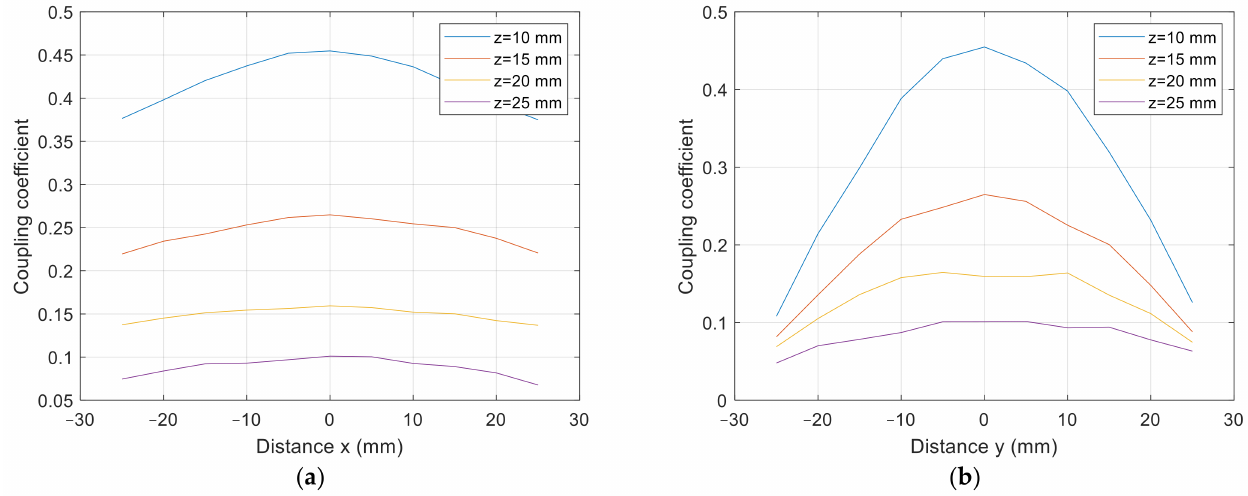
Figure 16. x - y coupling coefficient measurement of planar DD coils. ( a ) At y = 0 mm, at ( b ) x = 0